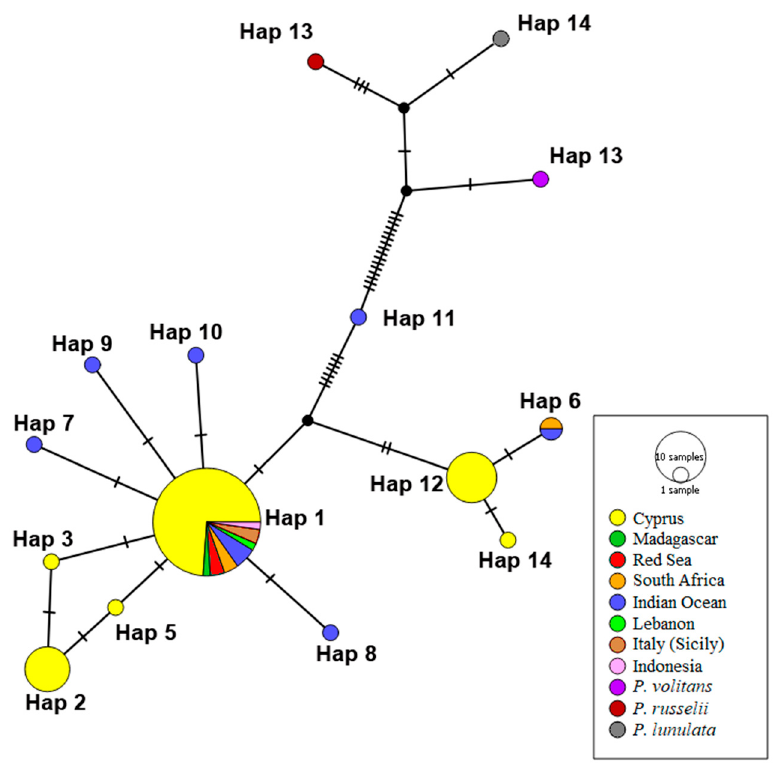
Figure 3. Median-joining haplotype network for CR sequences. Different colors correspond to geographic origin and circle size is proportional to the number of individuals with the same haplotype. Hatch marks along edges represent the number of mutations between nodes. Accession numbers for individuals representing each haplotype are given in Table S2.